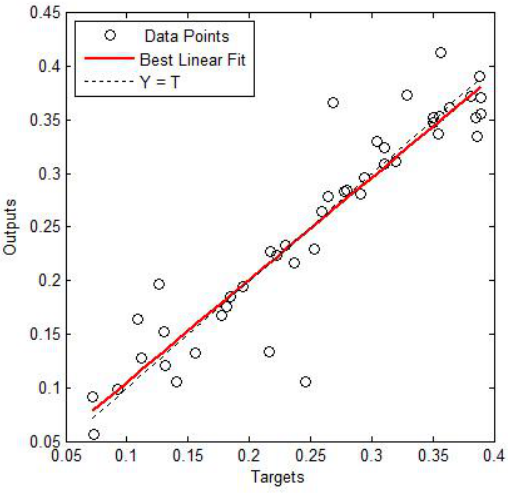
Fig. 6. Linear regression between the targets and outputs on the test data set,